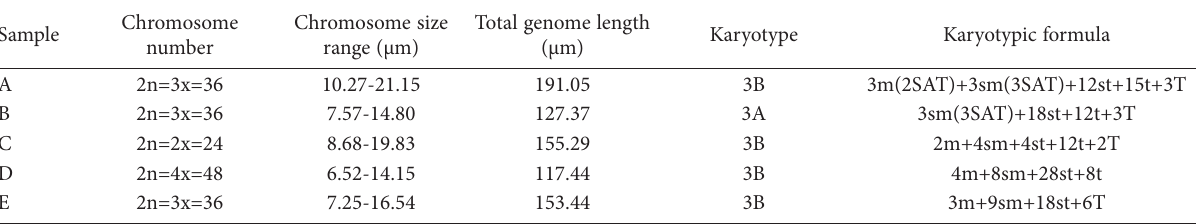
Table 1. Karyotype analysis of L. lancifolium and four related cultivars. Sample